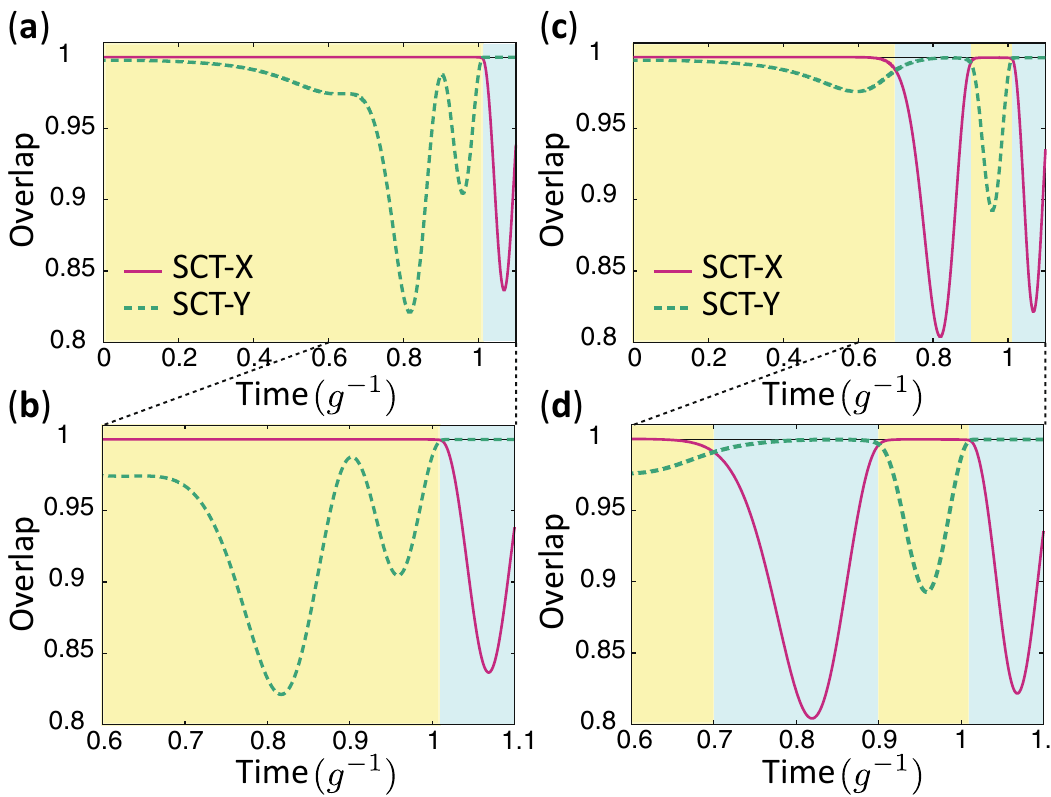
Figure 7. Overlaps with the speed-controlled trajectories. ( a,b ) are for ITT A and ( c,d ) are for ITT B. In the yellow region, the overlap with the SCT-X is larger than the one with the SCT-Y, while the overlap with the SCT-Y is larger than the one with the SCT-X in the blue